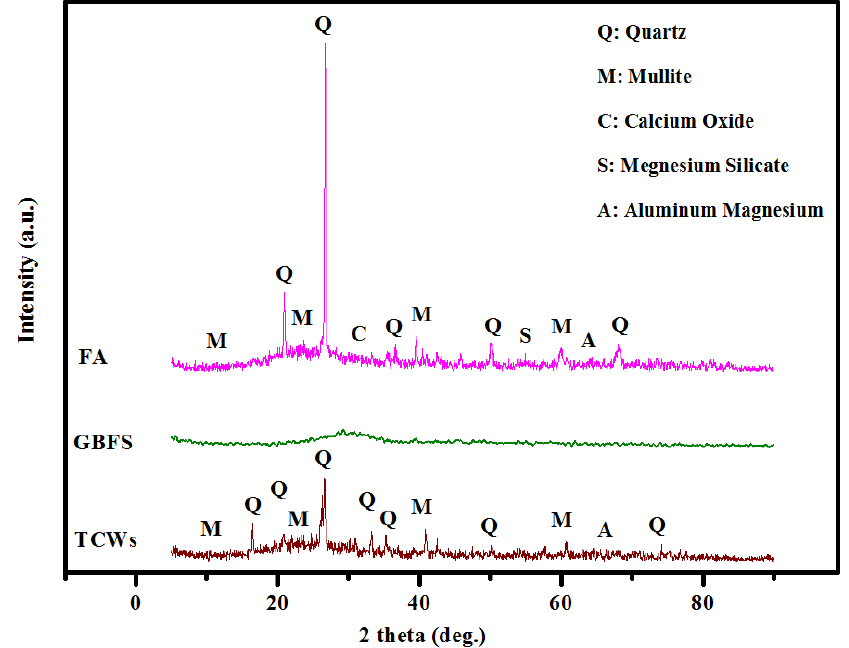
Figure 2. XRD patterns of raw materials included TCWs, GBFS and FA.